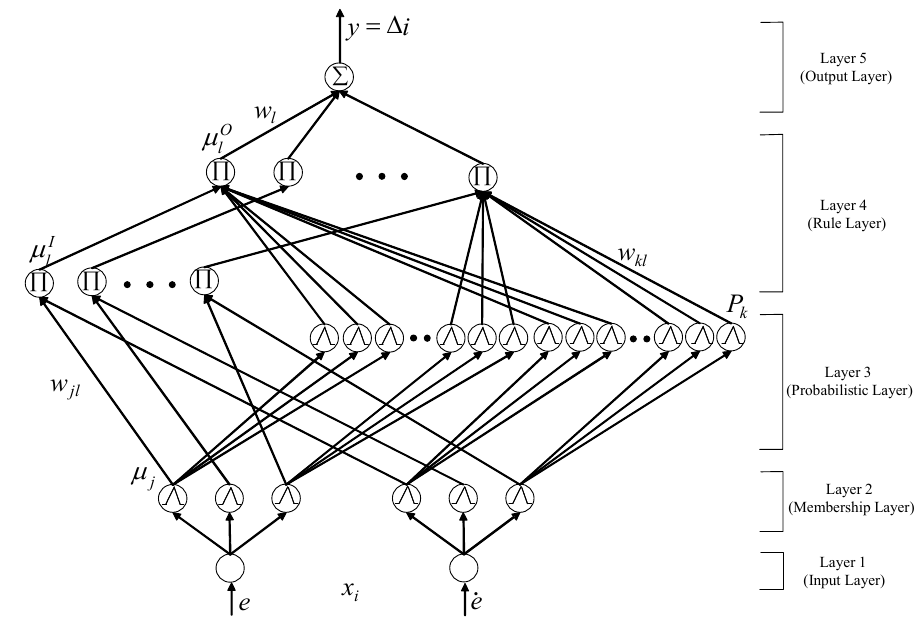
Figure 4. Network structure of PFNN.